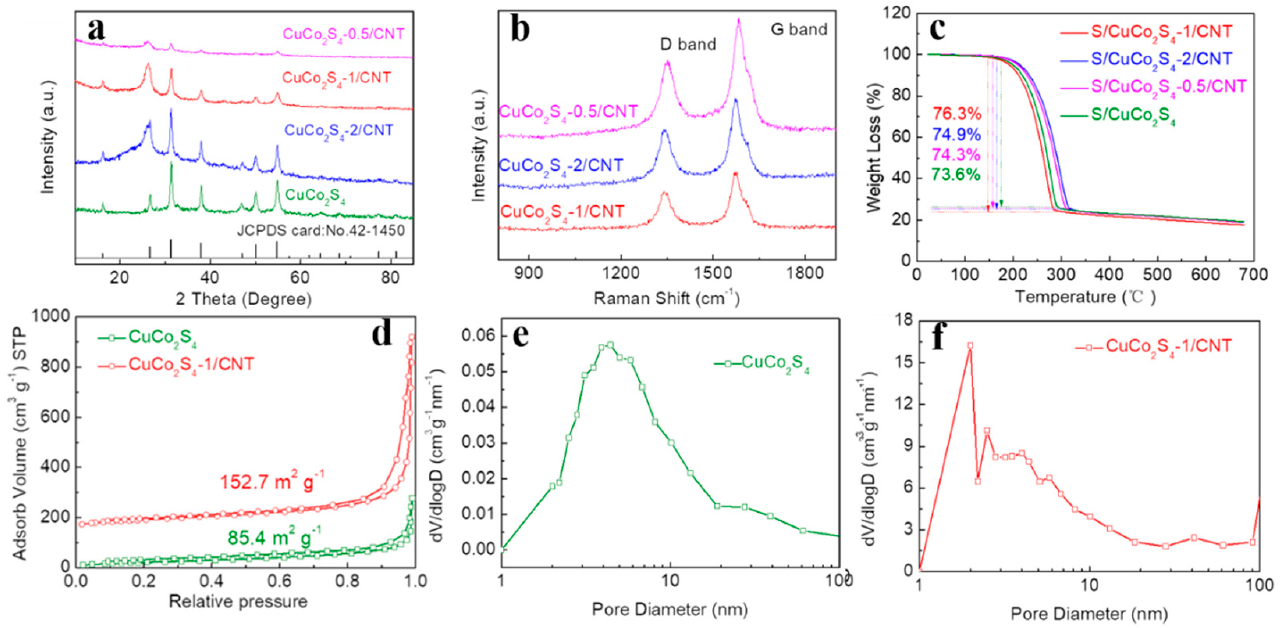
Figure 3. ( a ) XRD patterns of experimental materials. ( b ) Raman spectrum of CuCo 2 S 4 -0.5/CNT, CuCo 2 S 4 -1/CNT and CuCo 2 S 4 -2/CNT. ( c ) TGA plots of S/CuCo 2 S 4 , S/CuCo 2 S 4 -0.5/CNT, S/CuCo 2 S 4 - 1/CNT and S/CuCo 2 S 4 -2/CNT. ( d ) N 2 adsorption/desorption isotherms of CuCo 2 S 4 and CuCo 2 S 4 - 1/CNT. Pore size distribution of ( e ) CuCo 2 S 4 and ( f ) CuCo 2 S 4 -1/CNT.